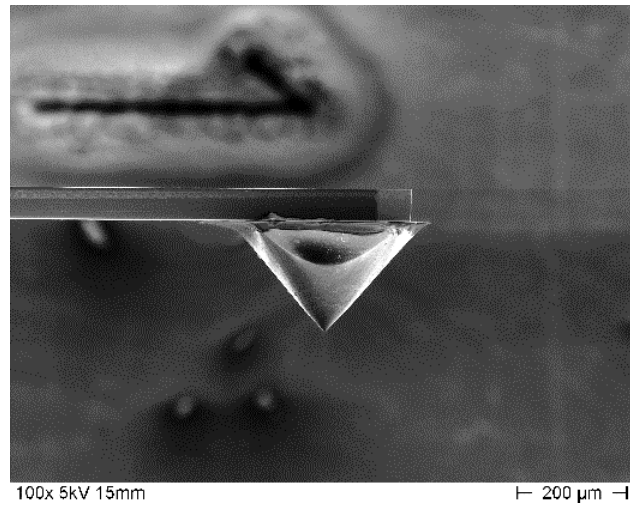
Figure 4. The microprobe with a glued 210 µm high diamond tip.